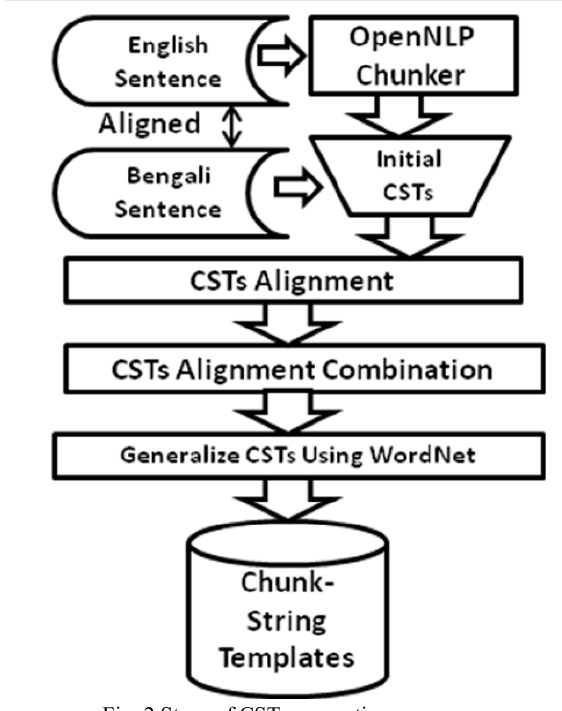
Fig. 2 Steps of CSTs generation